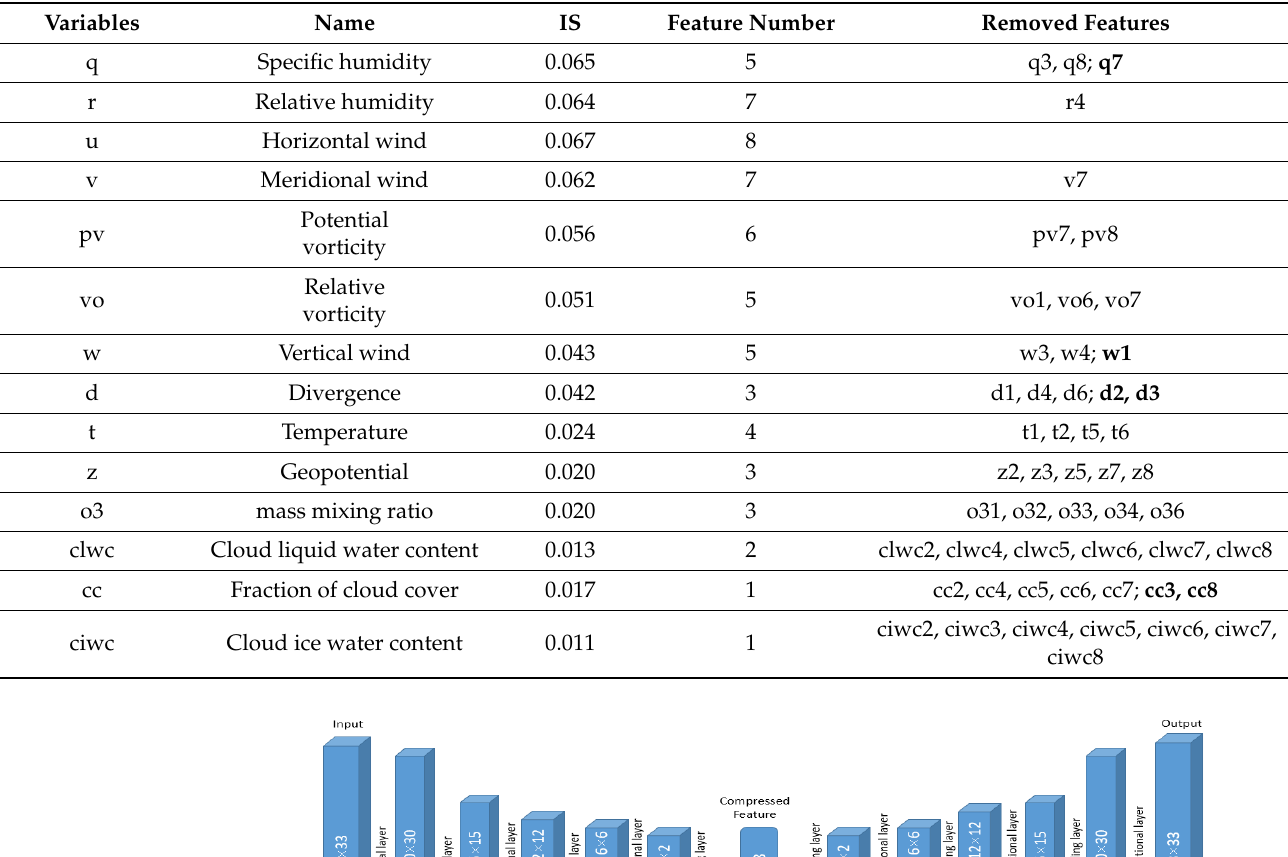
Table 1. The list of the 14 variables, their summed importance scores (IS), number of remaining features (Feature Number), and the specific removed variables due to all zero value and high correlation (bold font).